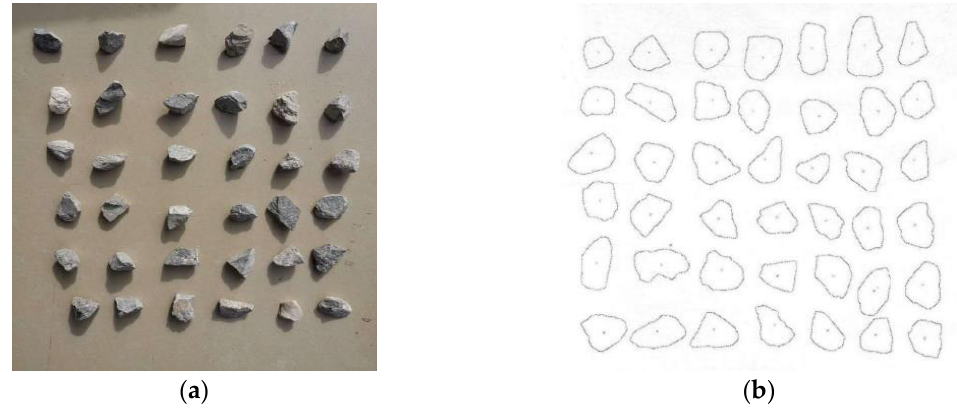
Figure 3. Aggregate image recognition. ( a ) Original photos of the coarse aggregate used for image